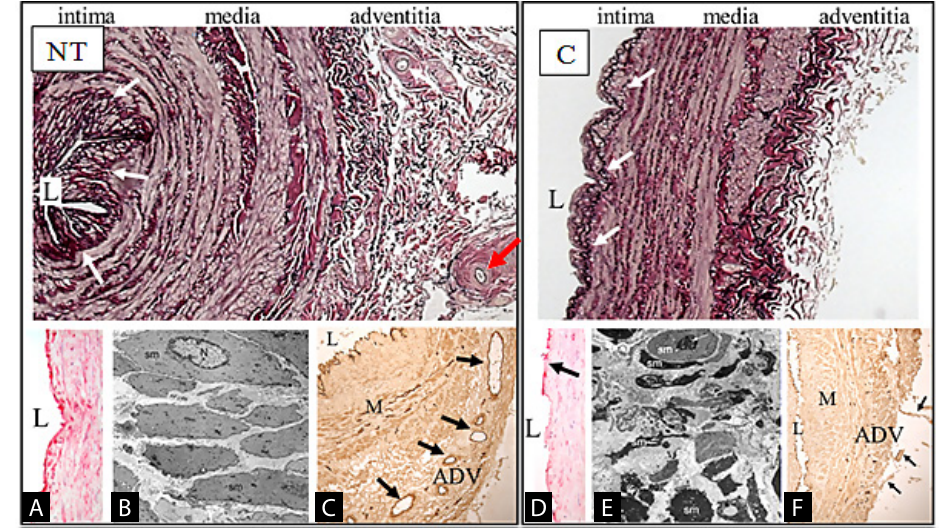
Fig. 3 – Histological, cellular, and ultrastructural comparison of no- touch (NT) vs. conventional (C) saphenous vein (SV) grafts. Top panels are representative